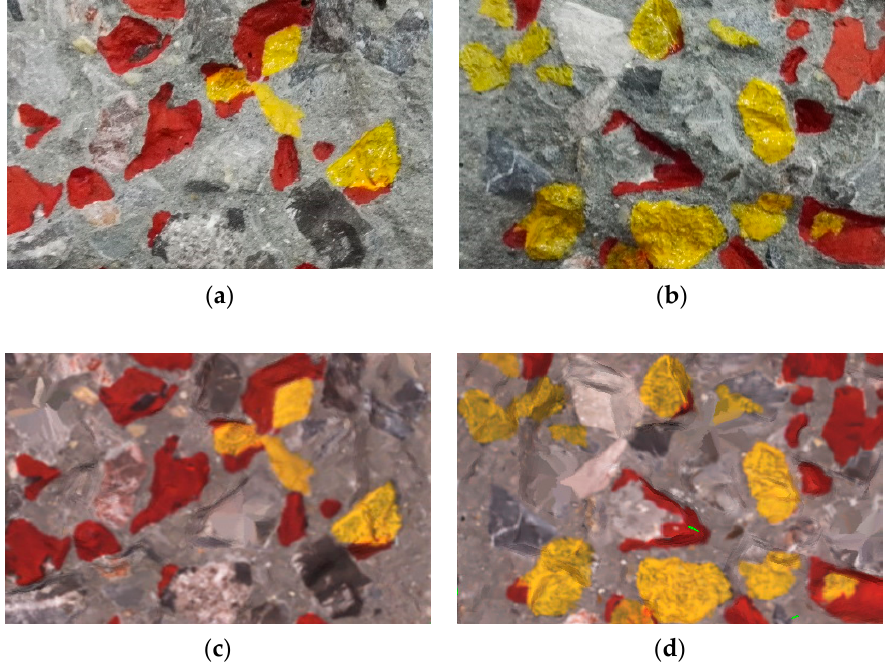
Figure 3. Real section profile ( a , b ) and 3D section profile generated by Handy SCAN ( c , d ) of the concrete specimen. ( a ) Side A, ( b ) Side B, ( c ) Side A and ( d ) Side B.